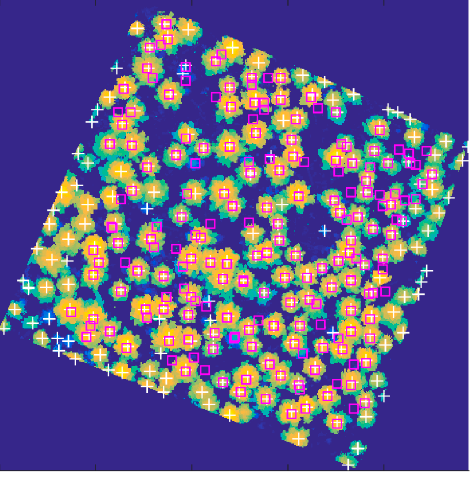
Figure 3. Result of individual tree detection (‘+’ in white: detected trees; □ : field-measured trees).